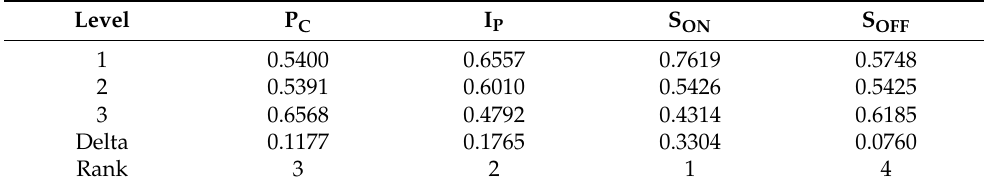
Table 8. Response of GRG.